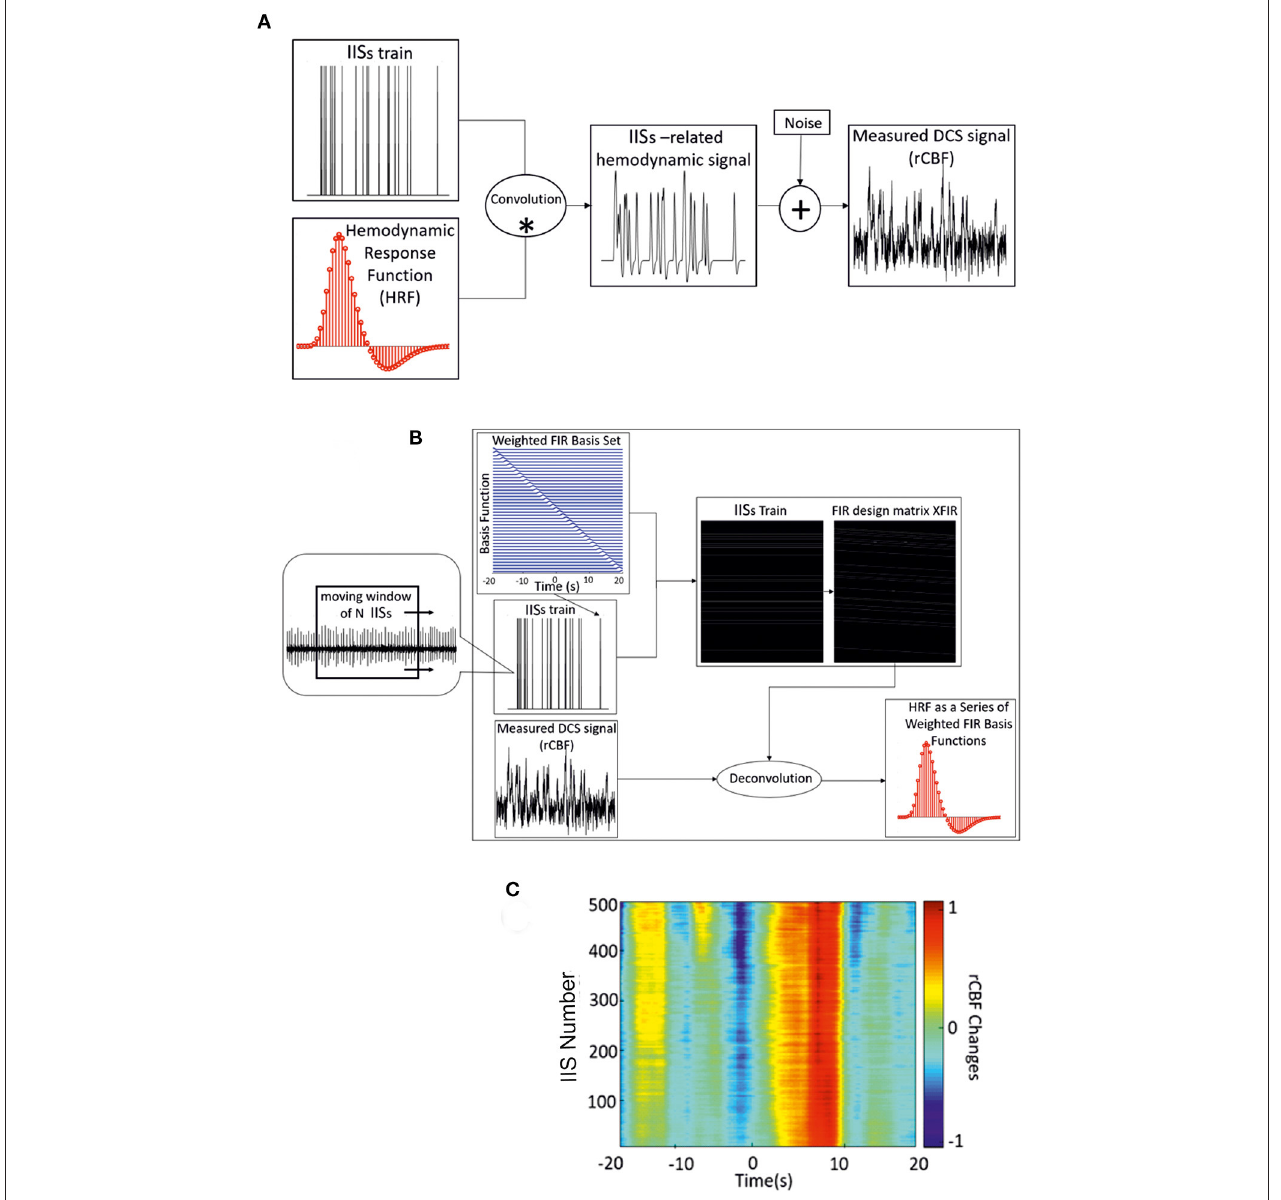
FIGURE 2 | (A) Linear convolution between an IIS train and the canonical HRF. (B) Deconvolution between the measured hemodynamic response and FIR design matrix X FIR , which is composed of sets of time-delayed impulses separated by intervals of 200ms (from − 20 to 20s) around the spike peaks. Dynamic approach of the deconvolution method used for IIS averaging (with a moving window of n IISs) and estimation of the hemodynamic response. (C) Time-course of rCBF changes for one rat using the dynamic FIR method. *: convolution; + :